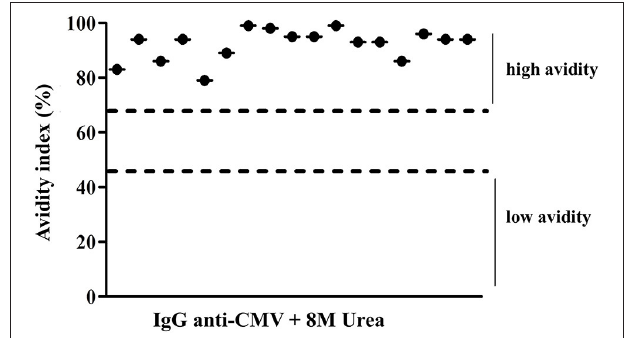
FIGURE 4 | Avidity index values of IgG CMV levels of positive patients to IgM CMV. Low avidity represented values < 45% and high avidity represented values >